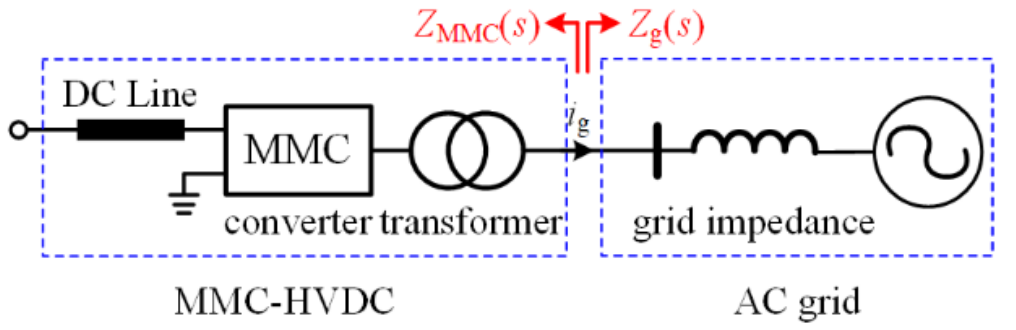
Figure 6. Block diagram of the MMC-HVDC integrated system.